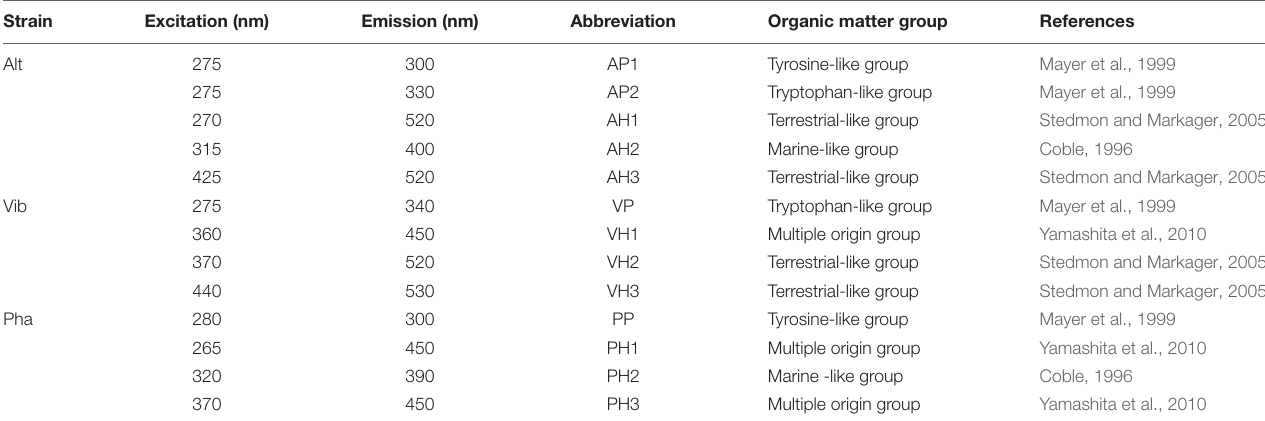
FIGURE 2 | Excitation-emission matrix (EEM) of the experimental treatment at the initiation of the incubation (upper row), the initiation of the stationary phase (middle row) and the end of the incubation (lower row) Alt (A–C) , Vib (D–F) , and Pha (G–I) treatments, respectively. The EEMs obtained from triplicate samples were averaged to produce the figures. TABLE 1 | Peak positions and groups of fluorescent dissolved organic matter produced by three bacterial strains.